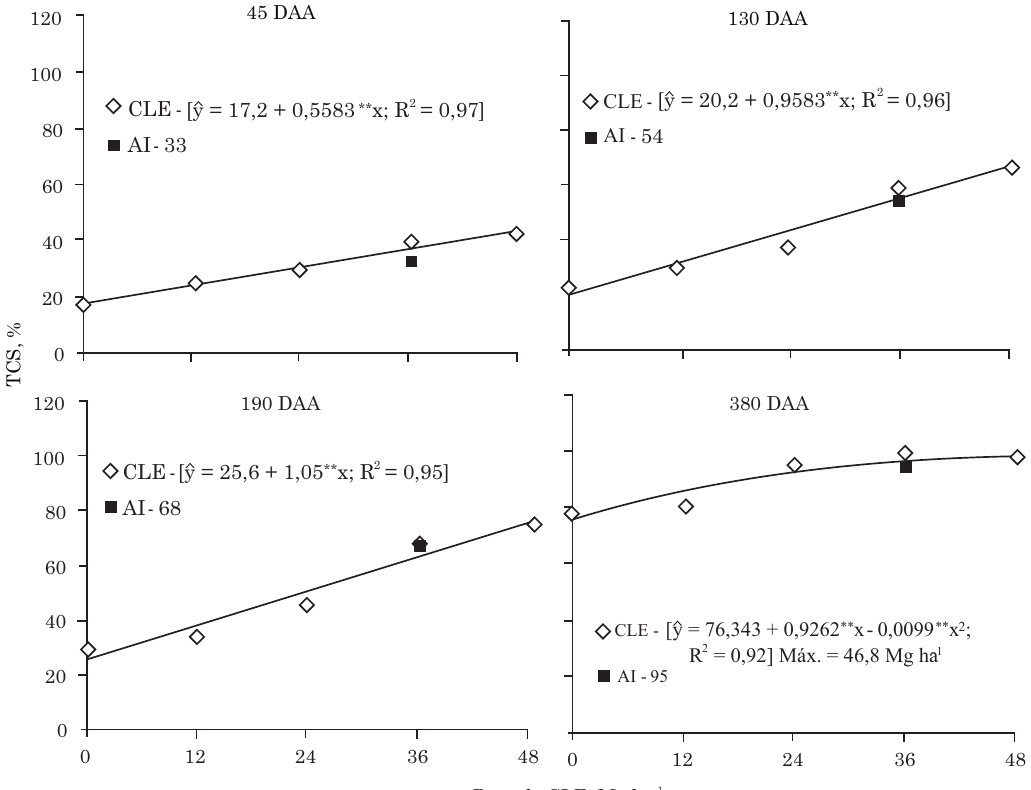
Figura 6. Taxa de cobertura do solo (TCS) pela grama Imperial em função de doses de composto de lodo de esgoto (CLE) aos 45, 135, 190 e 380 dias, após a aplicação (DAA). AI: adubação inorgânica.